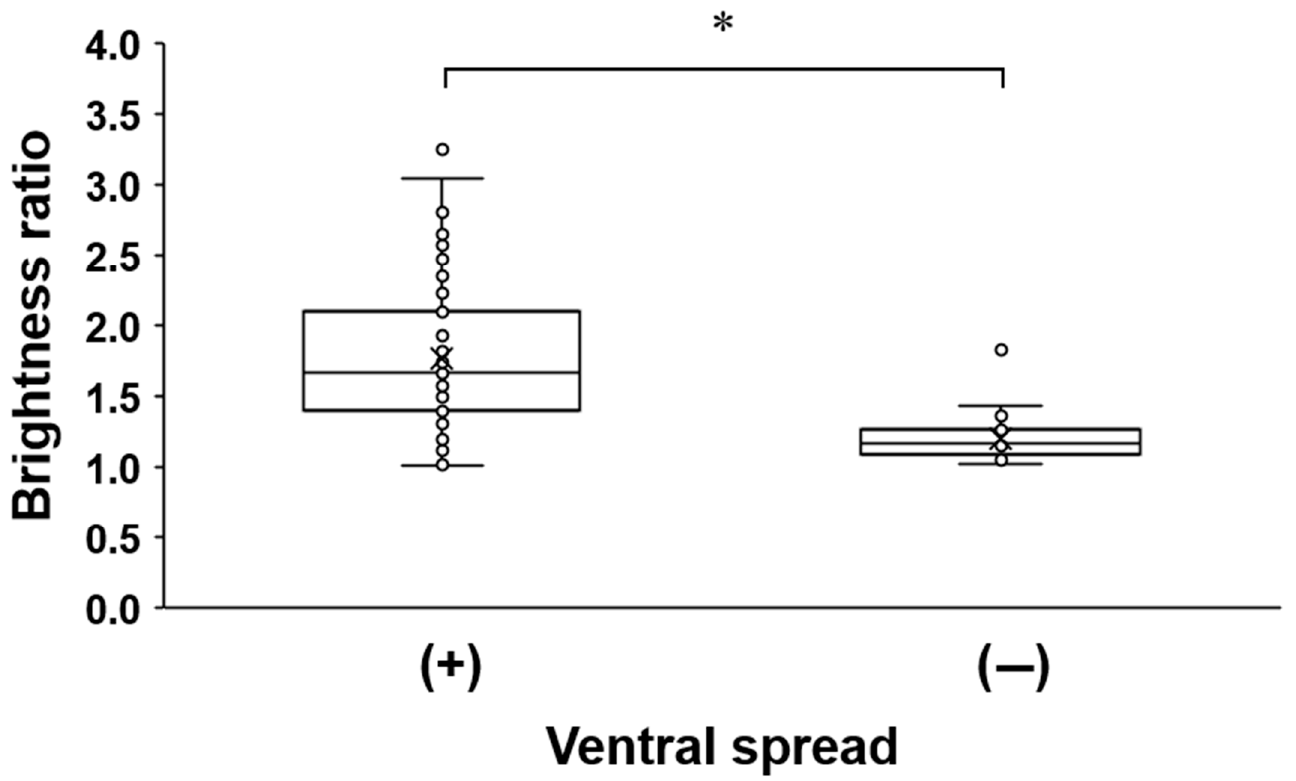
Figure 4. Association between ventral spread and grayscale brightness ratio. * p < 0.001. Table 1. Patients’ baseline and clinical characteristics.